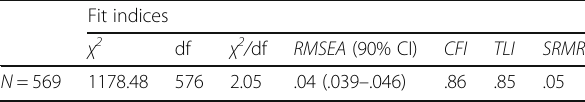
Table 2 Results of the confirmatory factor analyses for the DISC: 18 schema-based factors plus superordinate general factor Fit